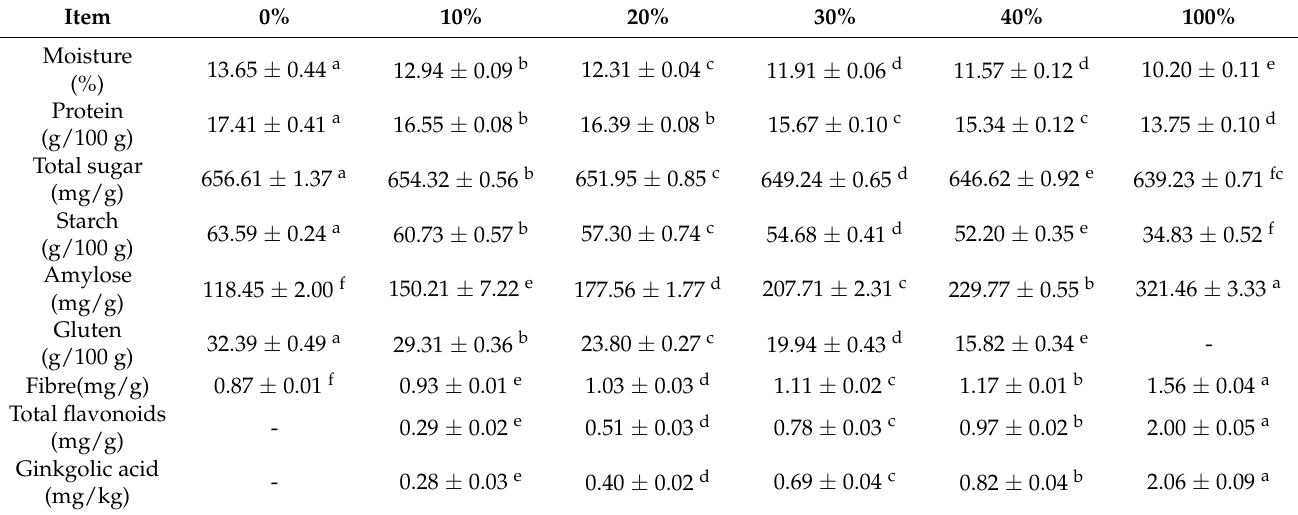
Table 2. Main chemical compositions of GBP/wheat flour